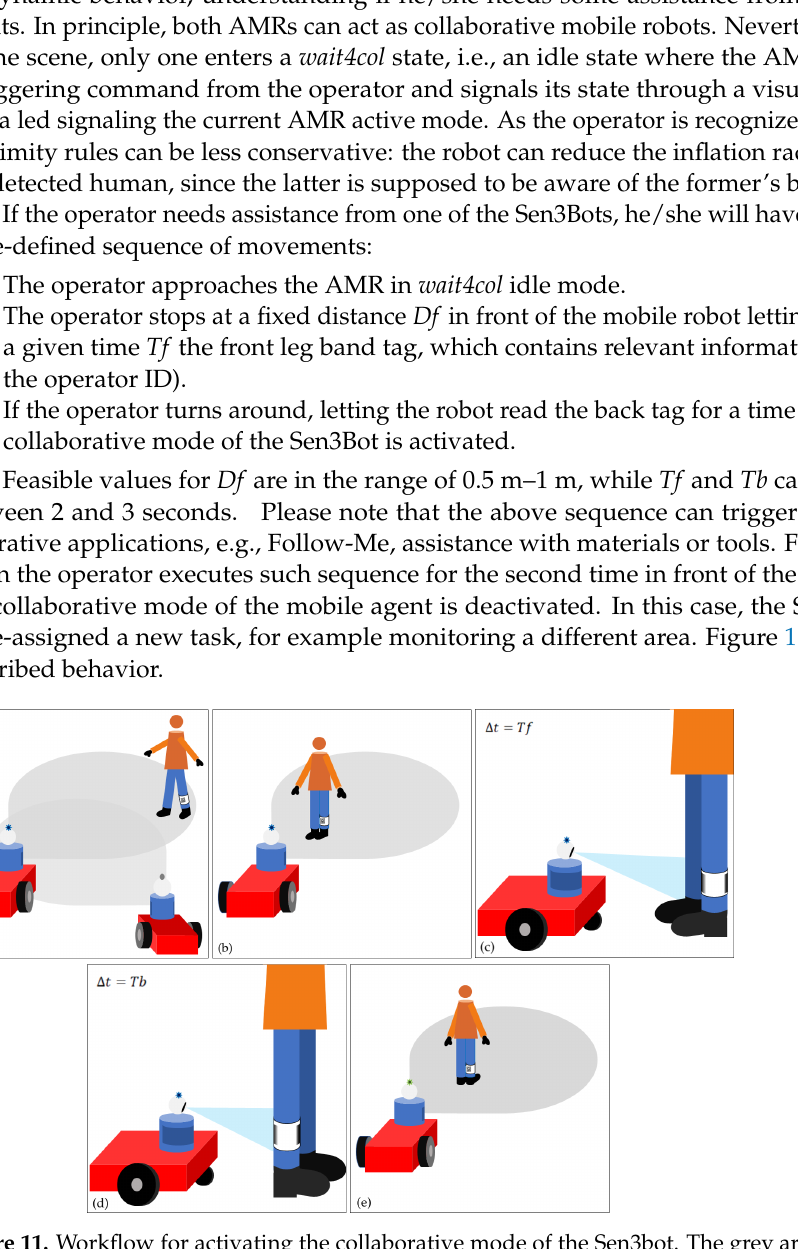
Figure 11. Workflow for activating the collaborative mode of the Sen3bot. The grey area represents the intersection of the vision and laser sensors FOV. ( a ) A human operator within the monitored area of type 2 needs assistance from one of the Sen3Bots. ( b ) Given the led blue color, the operator identifies the Sen3Bot ready for collaboration. ( c ) The human operator stops at a distance Df allowing the robot to scan its front QR code. ( d ) The human operator turns around allowing the robot to scan its back QR code. ( e ) The green indicator light indicates that the mobile robot entered the collaborative